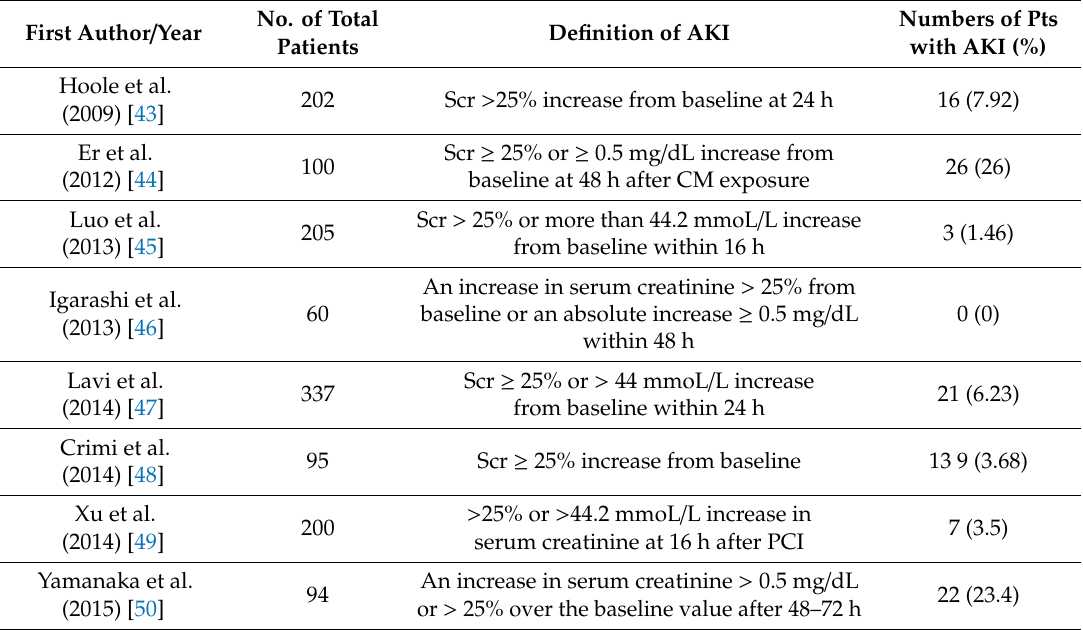
Table 3. AKI in patients undergoing PCI / coronary